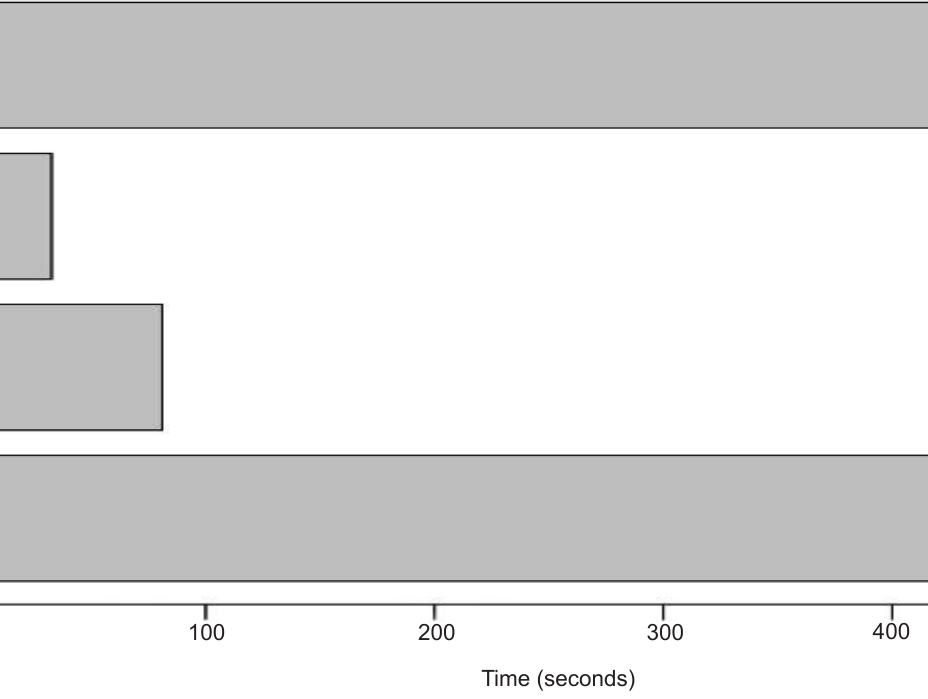
Nursing.Time Figure 4. Time to Solution (TtS) of trained vs untrained groups in airway obstruction station, as well as emergency medical services and healthcare (nursing graduates) professionals (p-value = 0.008729, confidence interval [CI], [-∞, -191.5561]). Engine Co, fire department first responders; BSN, Bachelor of Science with a major in